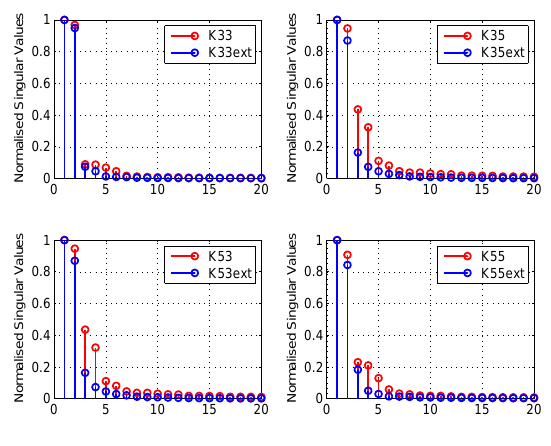
Figure 5: Singular values of the Hankel matrix of the samples of the impulse